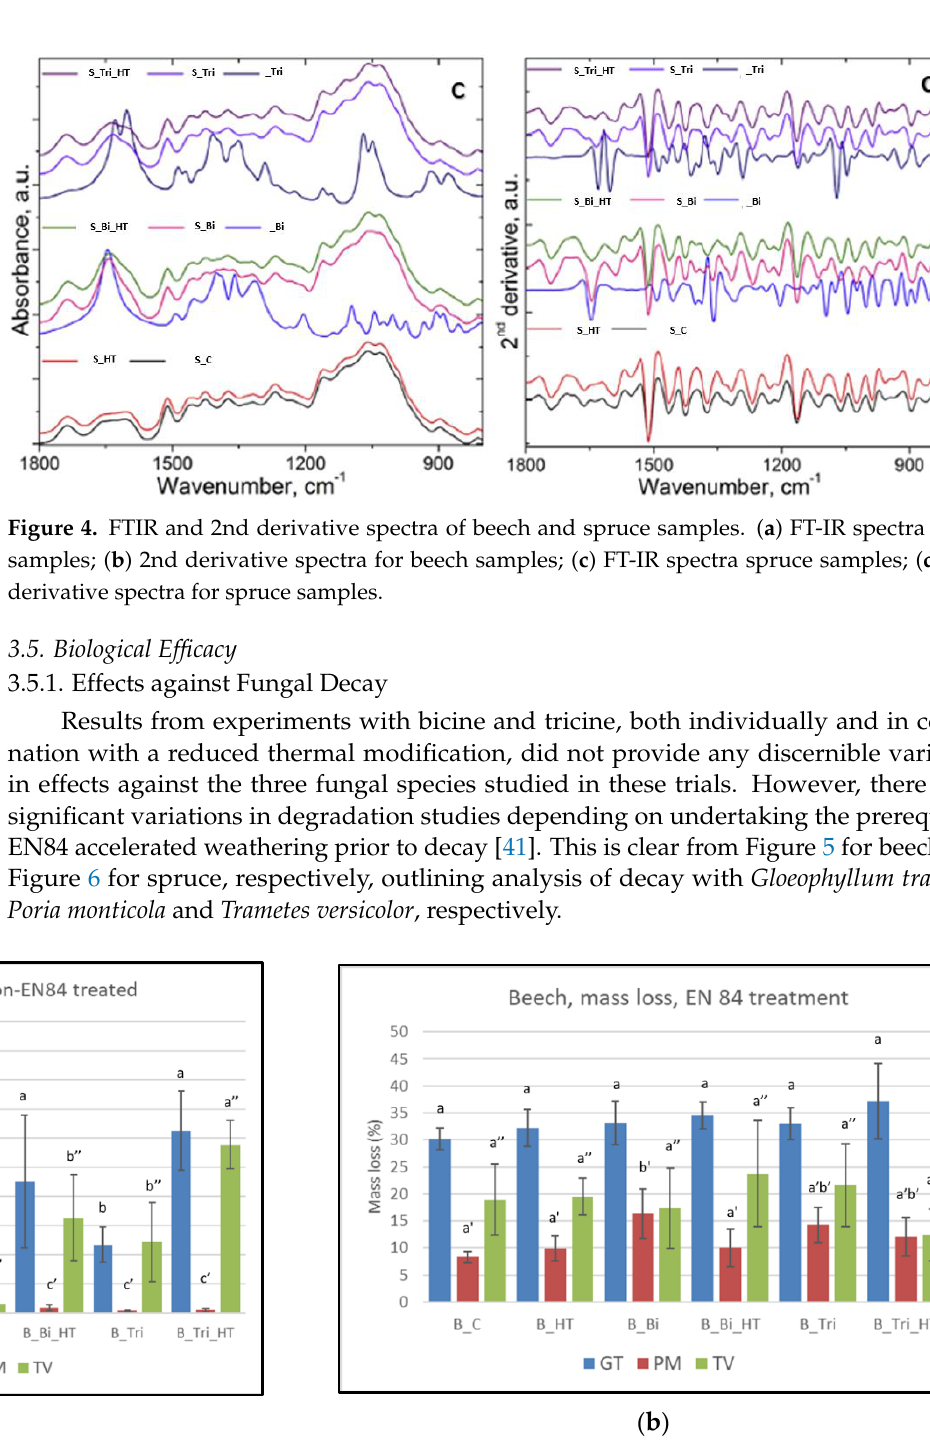
Figure 5. Mass loss of beech as a result of fungal decay, ( a ) without EN84 weathering; ( b ) with EN84 weathering. GT— G. trabeum , PM— P. monticola, TV— T. versicolor . Tukey analysis groups shown above each bar graph.